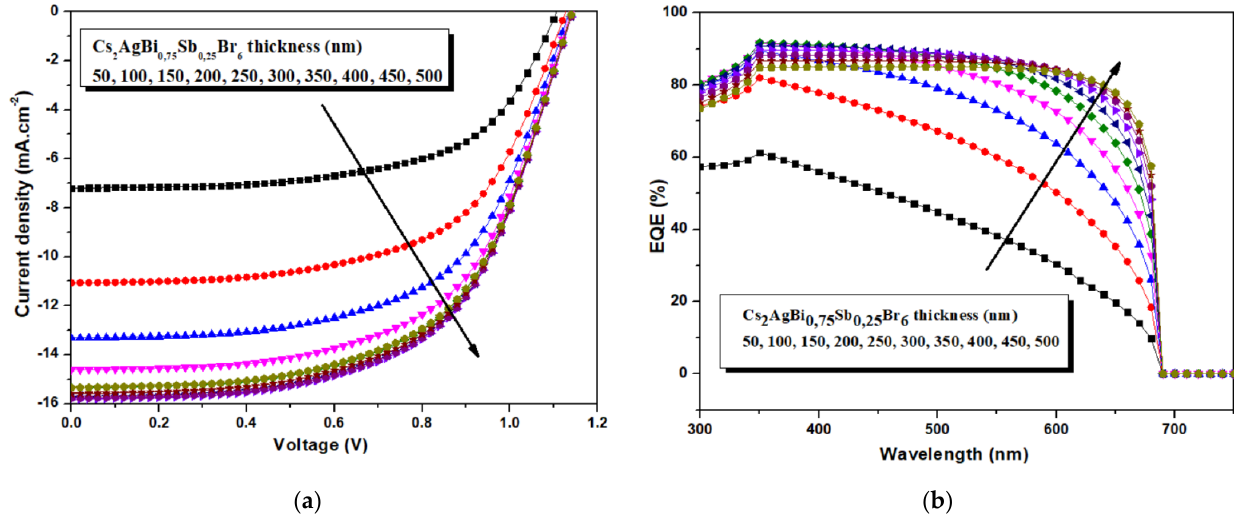
Figure 9. Effect of the standalone perovskite absorber layer thickness on ( a ) the J – V curve and ( b ) external quantum efficiency.